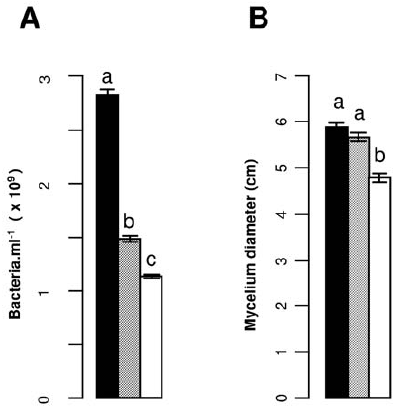
Figure 6. Effect of chlorogenic acid on pathogen growth. Pathogen growth was determined in culture medium enriched with chlorogenic acid to 0, 200 and 350 m g.ml 2 1 . Concentrations of Pectobacterium atrosepticum in liquid culture were determined after 40 h of contact (A). Radial mycelium growth of Phytophthora infestans from mycelia disks on solid culture medium was measured after 7 days (B). Bars represent the means 6 standard error of results from two replicate experiments. Different letters above bars indicate significant differences between treatments (Tukey’s test, p , 0.05).